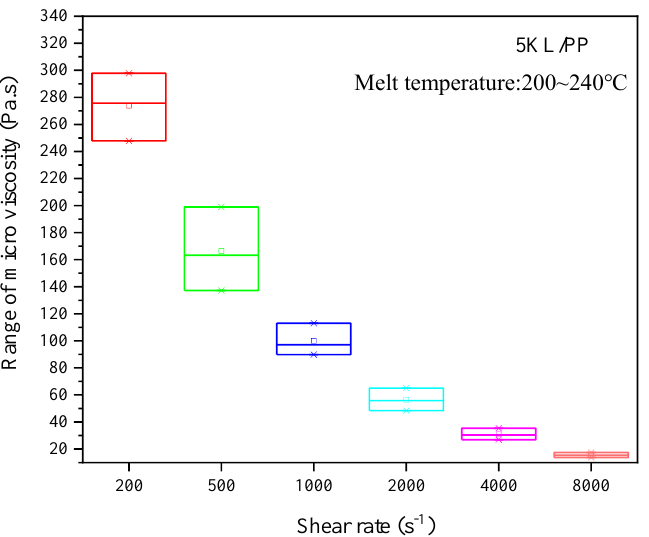
Figure 9. Effect of temperatures on the microviscosity under different shear rates in the form of standard deviation.